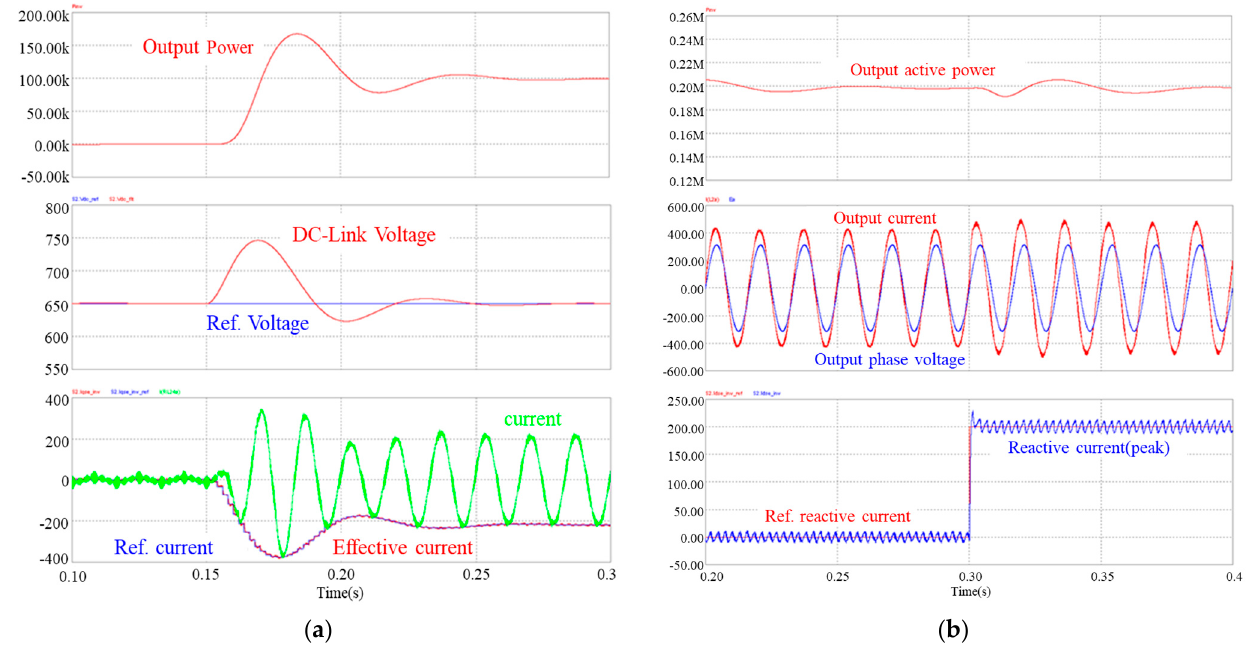
Figure 7. ( a ) DC-link controller power at 650 V after variable power and ( b ) power factor control.